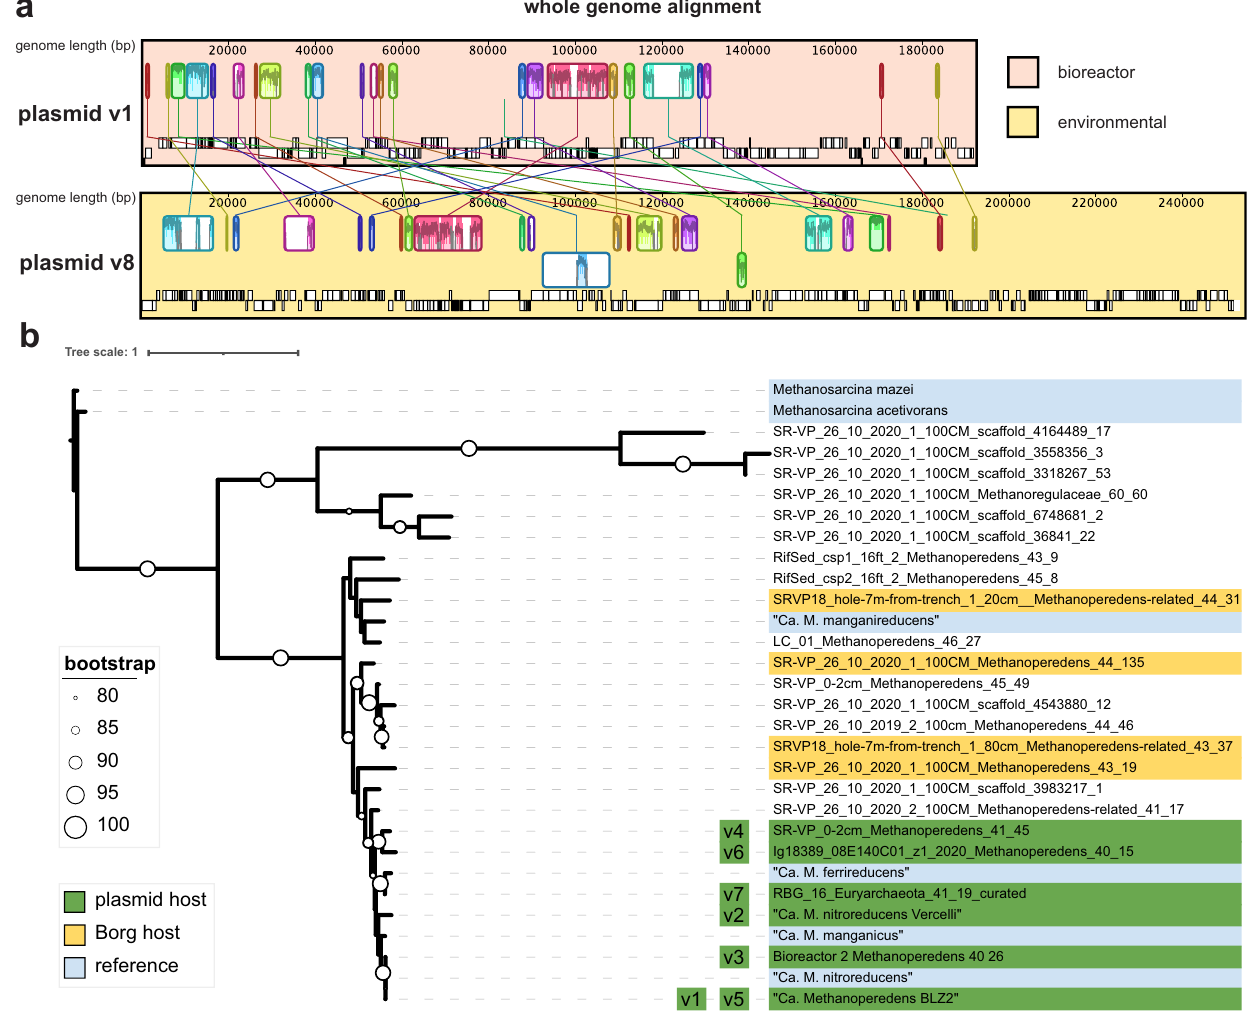
Fig. 1 | Genome alignment ofplasmidversionsv1 and v8 and phylogenetic tree of different Methanoperedens species. a All nine contigs of HMp_v8 were sorted and aligned onto the complete genome of HMp_v1 using the MCM algorithm in Geneious. Homologous regions of sequence shared by both plasmids (collinear